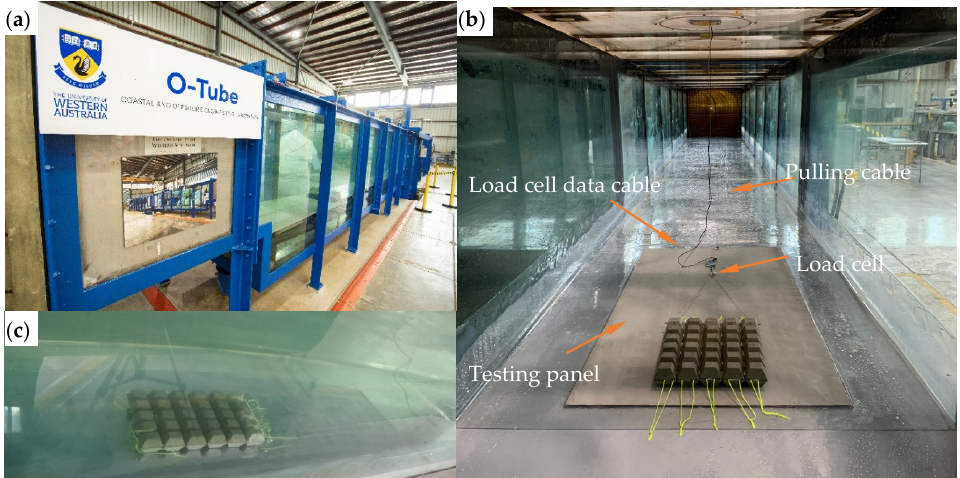
Figure 3. The model test setup. ( a ) The O-Tube facility, ( b ) the ACM model with load cell and pulling system. ( c ) Photo of the model from outside of the test section. The red line in ( b ) is an indication of the pulling cable which is 0.5 mm thick and could not be seen in this picture.